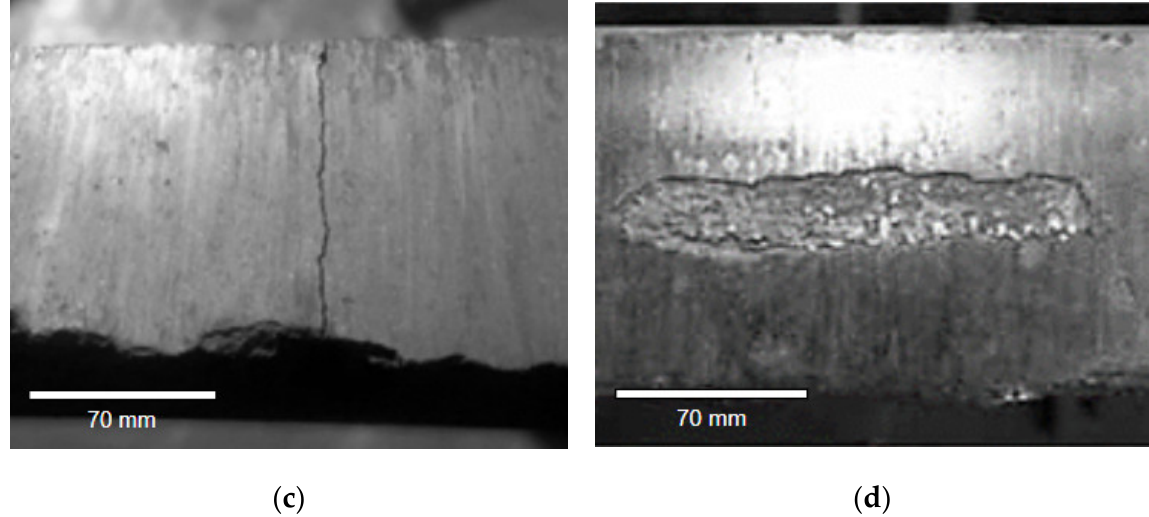
Figure 2. Wear of the sliding: ( a ) material melting as a result of arcing; ( b ) detachment of a piece of carbon strip; ( c ) crack of a strip; and ( d ) the top layer of a strip is peeling off [30].